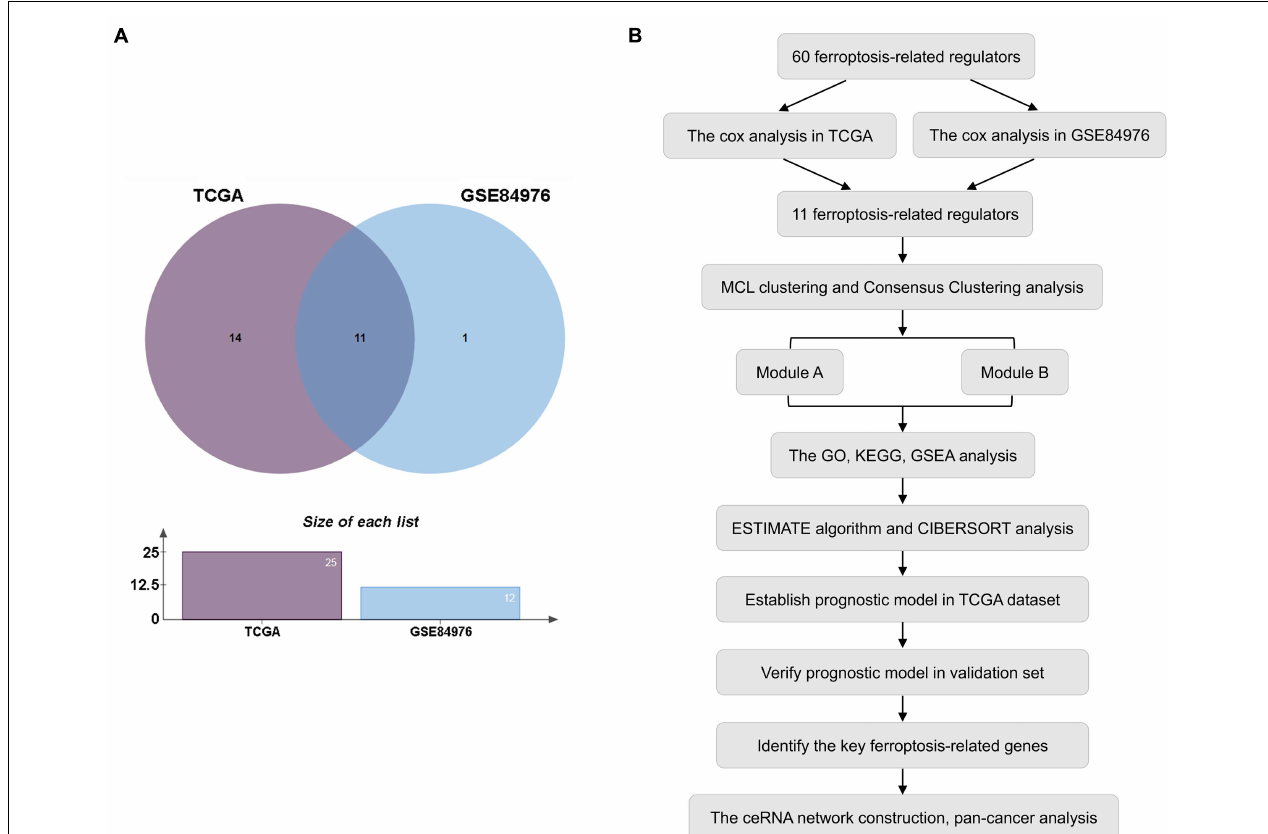
FIGURE 1 | Selection of prognostic regulators. (A) Venn plot of ferroptosis-related regulators. (B) Study flow chart.